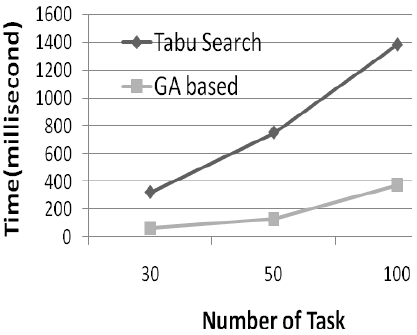
Figureure. 15. Compare with Tabu search approach